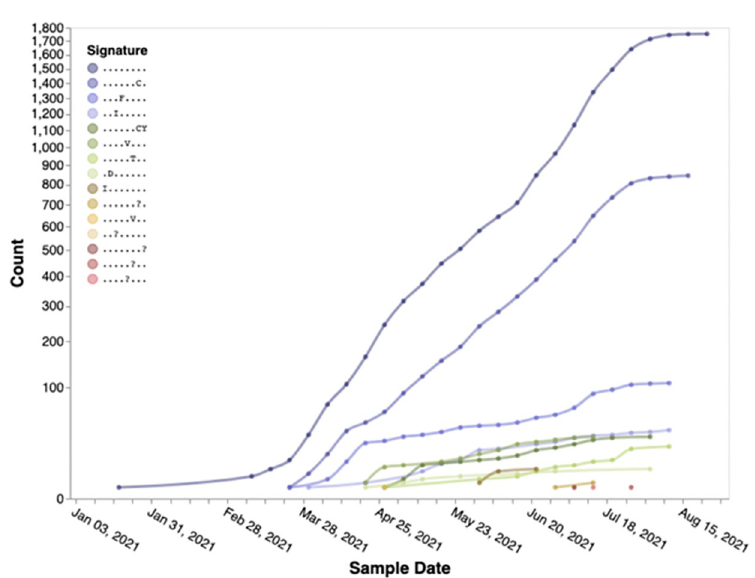
Fig 5. Temporal trends of the substitution combinations at all sites represented in Table 4 in the RDRP (RNA- dependent RNA polymerase) gene for B.1.621 ( μ ) sequences in 2021 (from left to right: RDRP/26, RDRP/228, RDRP/344, RDRP/364, RDRP/443, RDRP/449, RDRP/521, RDRP/879). The symbol “.” denotes the reference residue at that site. Figures like this can be generated using Trends in mutational patterns across SARS-CoV-2 Spike enabled by data from https://observablehq.com/@spond/spike-trends. Additional search parameters include “B.1.621 [pangolin] AND 20210101[after]”. Notebook link https://observablehq.com/@spond/spike-trends.